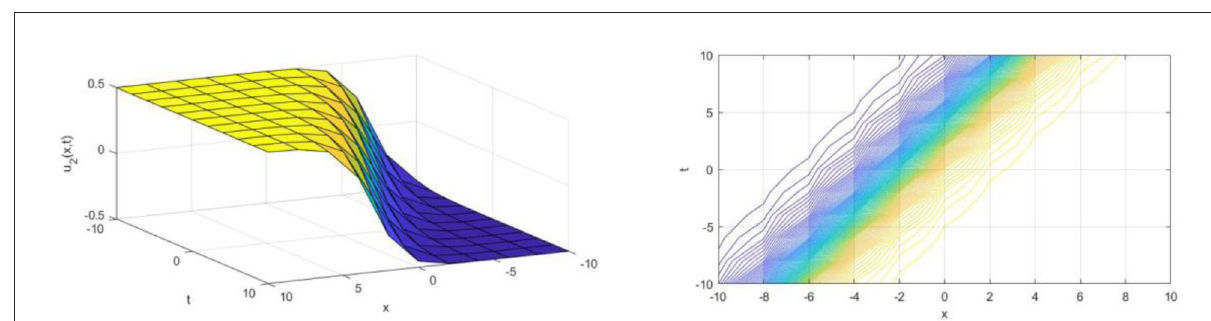
FIGURE2 The kink wave solution of u 2 ( x , t ) in 3D and contour.